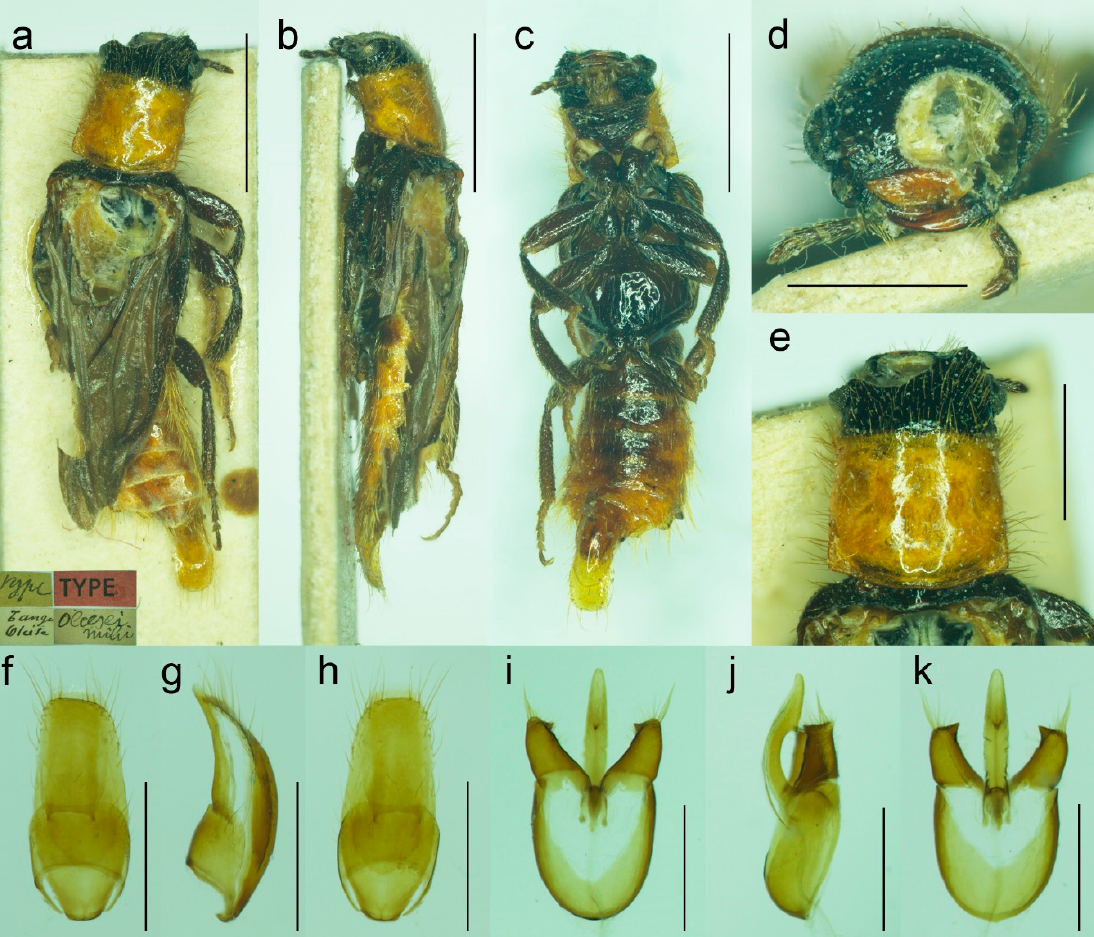
Figure 17. Malacogaster passerinii Bassi, 1834. Male lectotype of Malacogaster olcesei Pic, 1949, syn. nov. ( a ) Habitus, dorsal view; ( b ) habitus, lateral view; ( c ) habitus, ventral view; ( d ) head, frontal view; ( e ) pronotum, dorsal view; ( f ) genital capsule formed by tergites IX and X, and sternite IX, dorsal view; ( g ) genital capsule formed by tergites IX and X, and sternite IX, lateral view; ( h ) genital capsule formed by tergites IX and X, and sternite IX, ventral view; ( i ) aedeagus, dorsal view; ( j ) aedeagus, lateral view; ( k ) aedeagus, ventral view. Scale bars = ( a – c ) 2.0 mm; ( d – h ) 1.0 mm; ( i – k ) 0.5 mm. Diagnostic redescription . Based on the lectotype. Male. Body (Figure 19a–c) 5.60 mm long, 2.80 times as long as wide; dark brown to black, prosternum posteriorly lighter, labrum, ventral portion of head, pronotum including hypomeron, and legs except coxae yellowish brown, abdomen yellowish to reddish brown. Body pubescence yellowish brown, setae on elytra yellowish to reddish brown. Head 1.15 times as wide as anterior margin of pronotum, and 1.10 times as wide as pronotum measured at widest place. Fronto-clypeal region (Figure 19e) short and wide, apically widely concave; eyes relatively large, their min- imum frontal separation 1.90 times maximum eye diameter; labrum large,